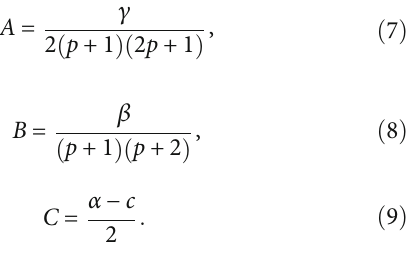
ð ξ Þ when κ = 0, p = 5, α − c = 0, β = − 3 , and γ ⟶ 0 + 0 1